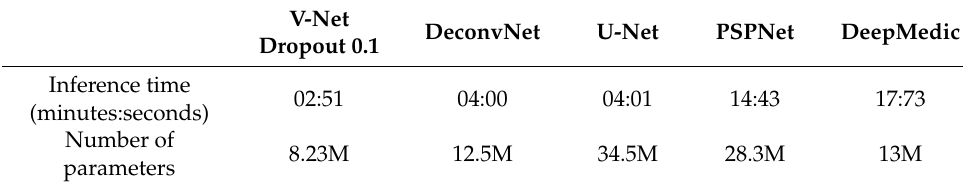
Table 6. Inference time on our hardware and parameters of different